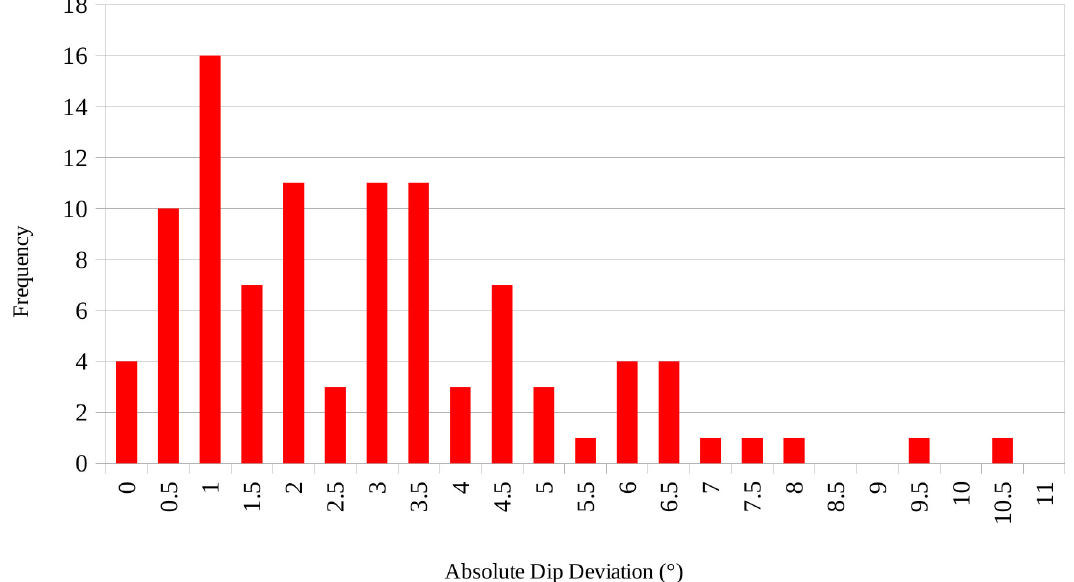
Figure 15. Histogram of pre-split holes’ absolute dip deviation for Mine C assessed using the UAV photogrammetric model shown in Figure 14. A total of 100 pre-split hole measurements are included in this